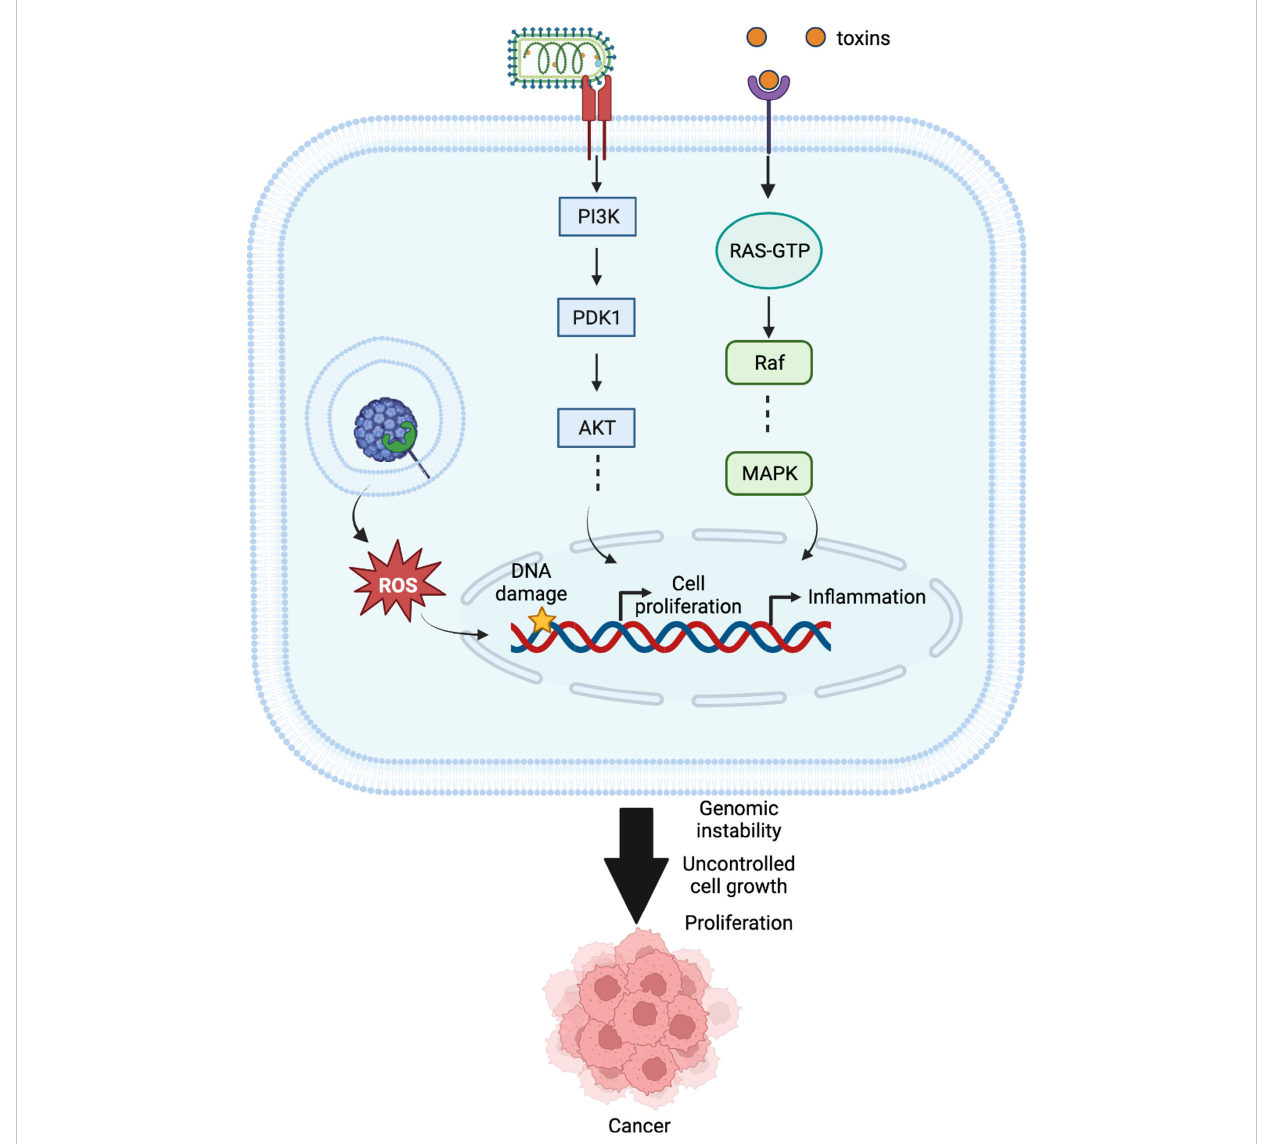
FIGURE 4 Different cellular mechanisms interfered by pathogens in host cells that might result in